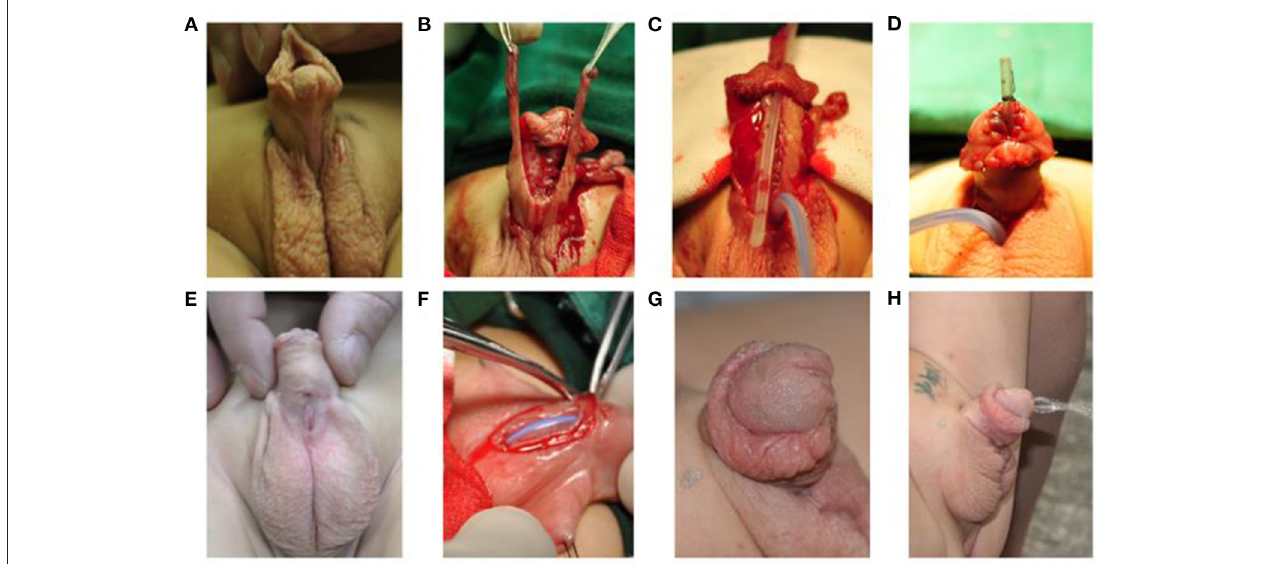
FIGURE 1 | Schematic plot for prefabricated urethra staged surgery. (A) Appearance before the first stage surgery; (B) “Wing-shaped” skin flaps separated from around the urethra; (C) Urethra formed by rolling the skin flap; (D) Support tube retained in the prefabricated urethra; (E) appearance before the second-stage surgery; (F) Urethra formed by anastomosis of the skin flap around the freed fistula; (G) Appearance after the second stage surgery; (H) Urination after the second-stage surgery.